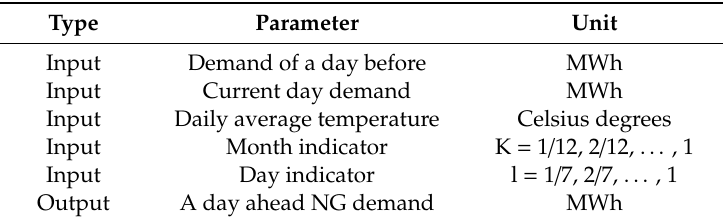
Table 2. Input and output